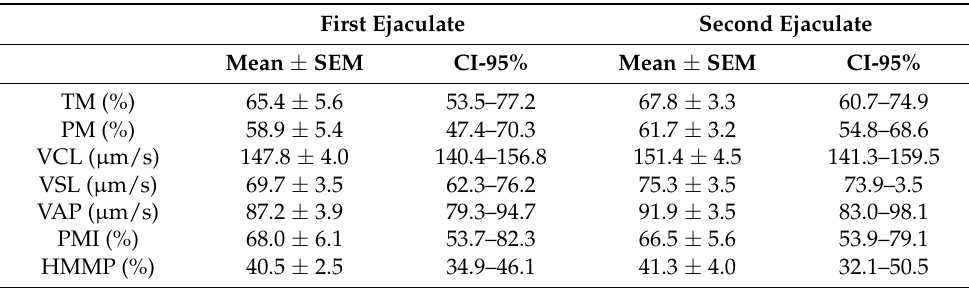
Table 6. Qualitative comparison of the first and second ejaculates collected from breeding inactive stallions (n =